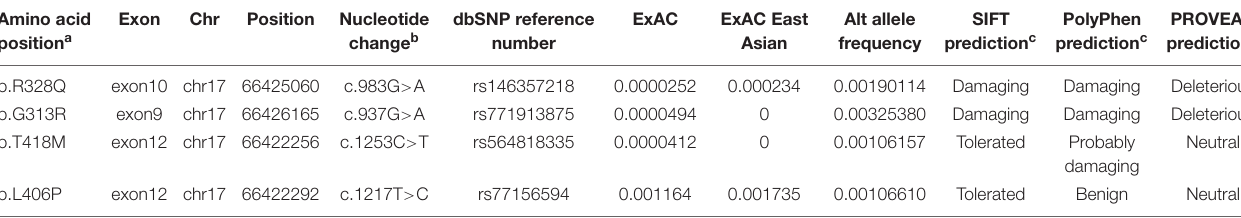
TABLE 2 | Variants within WIPI1 coding sequence identified in the NTD cases. Amino acid Exon Chr Position Nucleotide position a